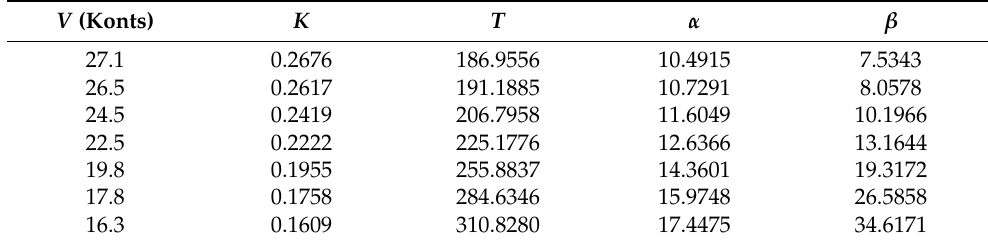
Table 1. Uncertain model parameters under different ship speed V